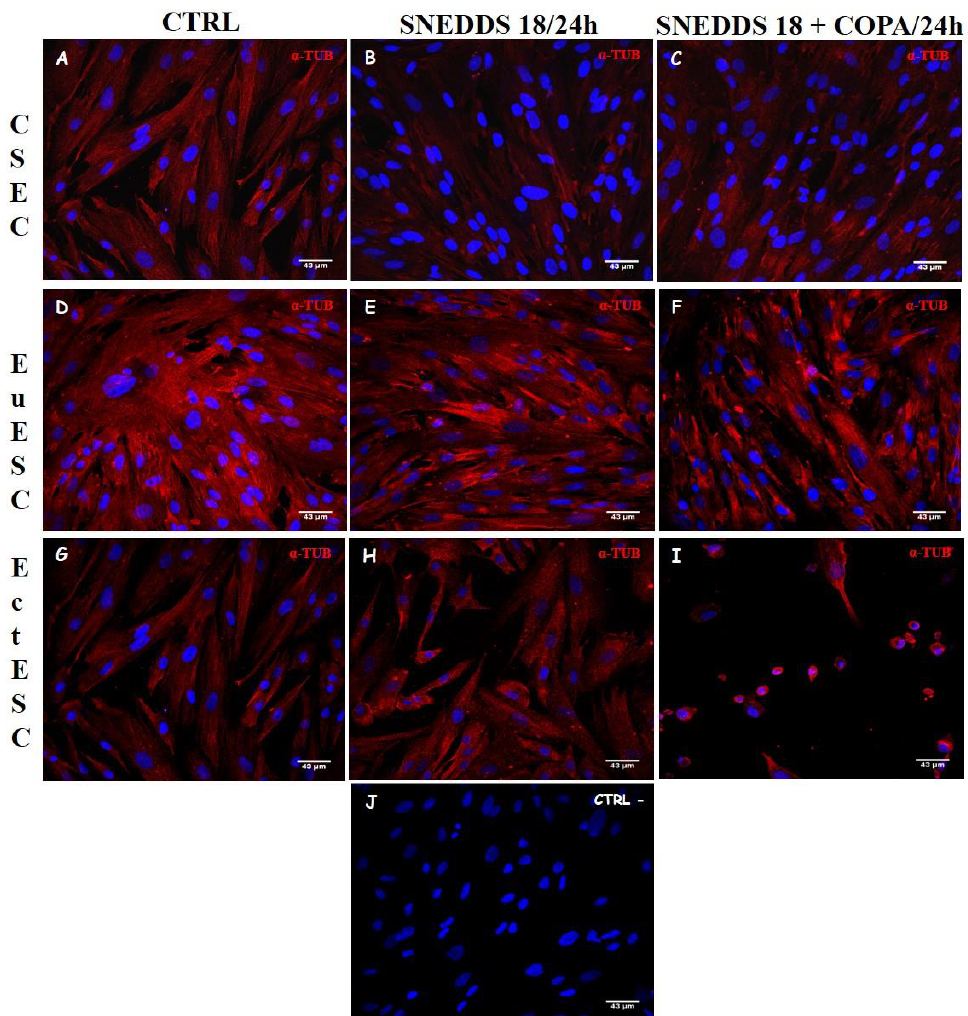
Figure 7. Analysis of tubulin structure of the ESC cultures after treatment with nanoemulsions. CESC ( A – C ), EuESC ( D – E ), and EctESC ( G – I ) were labeled with anti- α -tubulin antibody (red) or DAPI ( J , nuclear marker, blue) after 24 h of treatment with nanoemulsions (50 µg/mL). Scale bar = 43 µ m. CESC: Endometrial stromal cells obtained from topic endometrium of patients without endometriosis; EuESC: Endometrial stromal cells obtained from topic endometrium of endometriosis patients; EctESC: Endometrial stromal cells obtained from ectopic endometrium of endometriosis patients (endometriotic lesions).